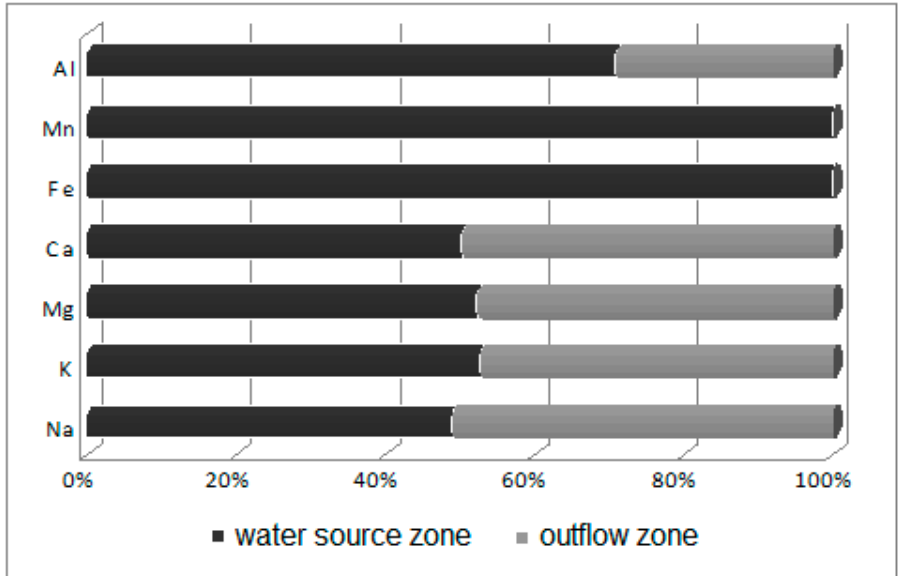
Figure 6. Ratio of water macroelement concentrations in the water source zone to those in the outflow zone. Diversity 2019 , 11 , x FOR PEER REVIEW Table 2. Chemical parameters of habitat of Potametum alpini Podbielkowski patches.